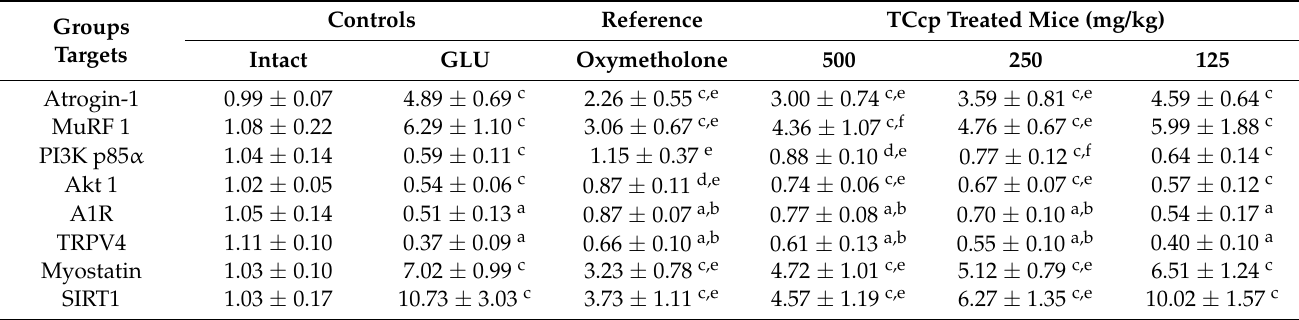
Table 5. Changes in gastrocnemius muscle mRNA expressions.